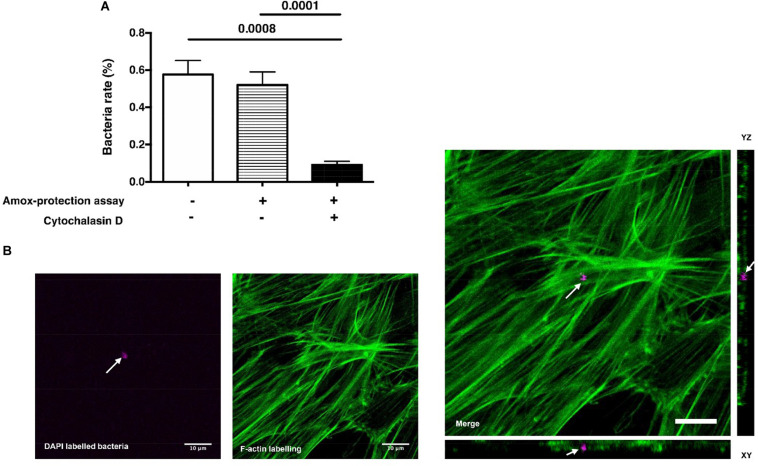
S. mutans internalization. (A) Percentage of viable S. mutans after 3 h of contact with dental pulp stem cells (DPSCs). Tests were performed with or without amoxicillin treatment (Amox-protection assay). S. mutans challenged with Cytochalasin D-treated DPSCs indicates that F-actin fibers are required for S. mutans internalization by DPSCs (Histograms of mean ± SEM, n = 6, Mann & Whitney test). (B) Laser scanning confocal microscopy visualization and orthogonal view of DPSCs infected with S. mutans. Green color corresponds to cytoskeleton labeled with Phalloidin-coupled to Alexa® 488 and magenta color corresponds to S. mutans labeled with DAPI. White arrows indicate bacteria. Scale bar = 10 μm.